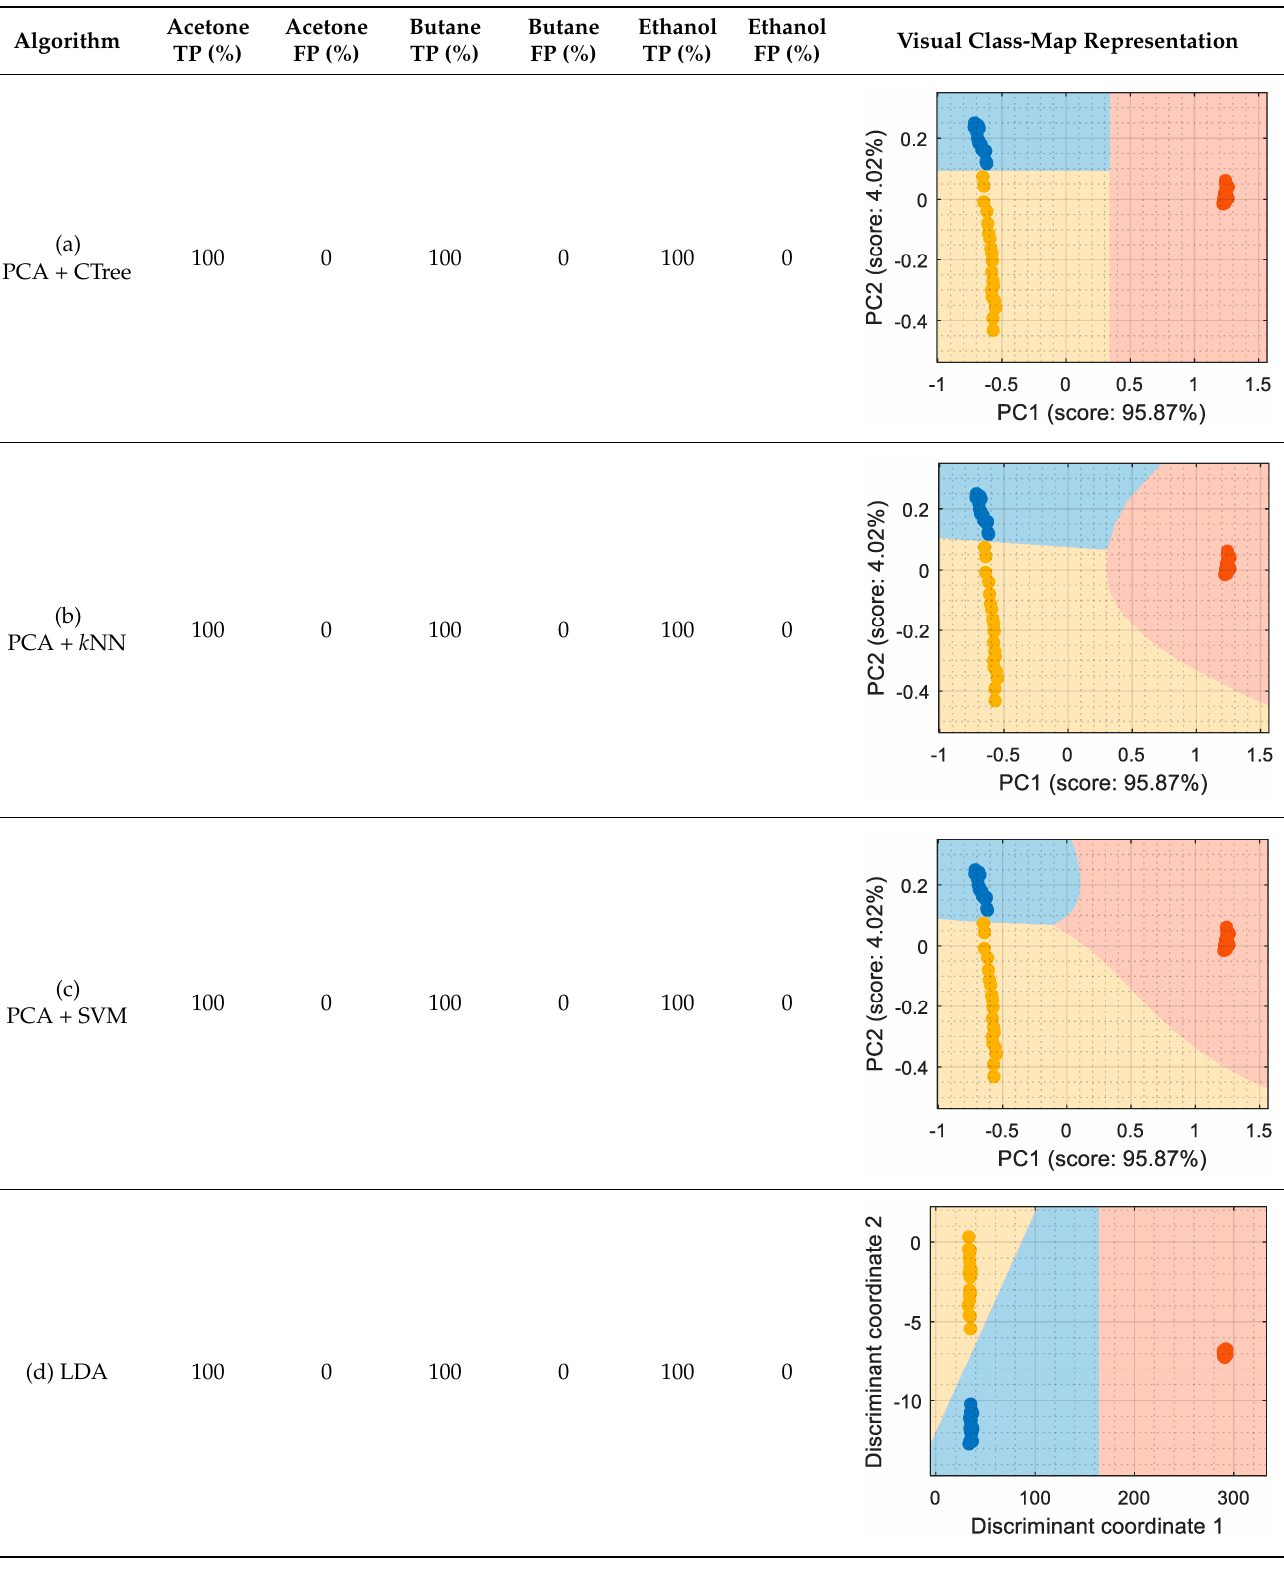
Table 3. Performance of the classifiers when processing the information gathered from the eNose as normalized resistance: representations of true positive (TP) and false positive